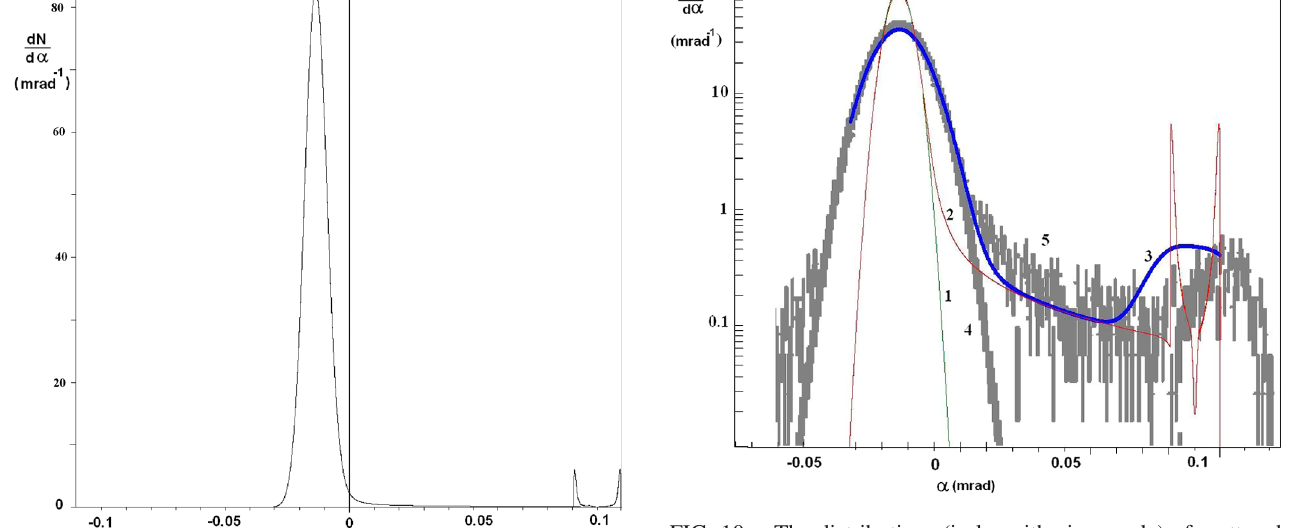
FIG. 10. The distributions (in logarithmic y-scale) of scattered particle at volume reflection of 400 GeV protons in (110) planes of silicon single crystal. The curve 1 is calculated for parallel beam without consideration of diffusion process (the transverse energy is conserved); the curve 2 is a calculation in which the influence of volume capture on a process taken into account; the curve 3 is a calculation in which the influence of volume capture and divergence of proton beam on a process taken into account; the curve 4 is the Gaussian approximation of experimental scattering curve; the curve 5 is the full experimental scattering curve. For additional information, see the